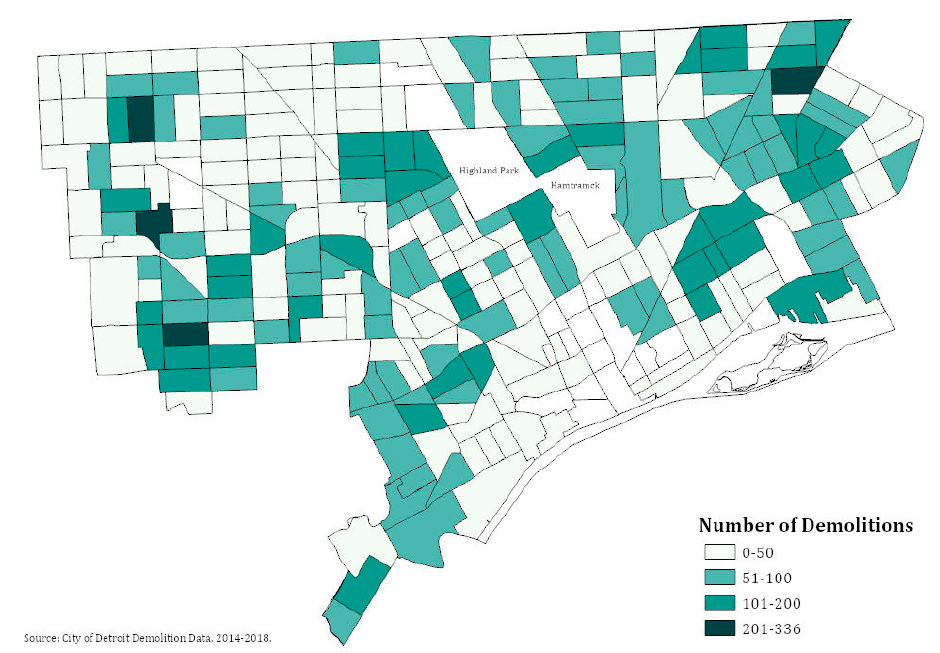
Figure 3. Number of demolitions by census tract in Detroit, 2014–2018. Note: Demolition data from City of Detroit Open Data Portal. Numbers represent the total number of demolitions between